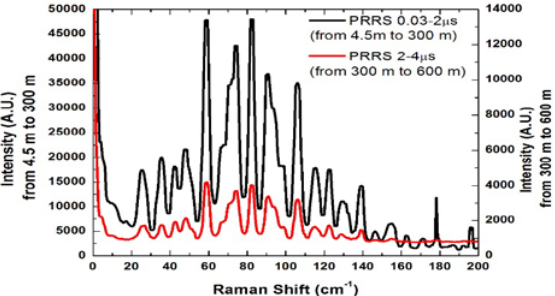
Fig. 2. Pure rotational Raman spectrum of air at 2017 UTC on 4 November 2017 averaged over 10 shots (1 s).